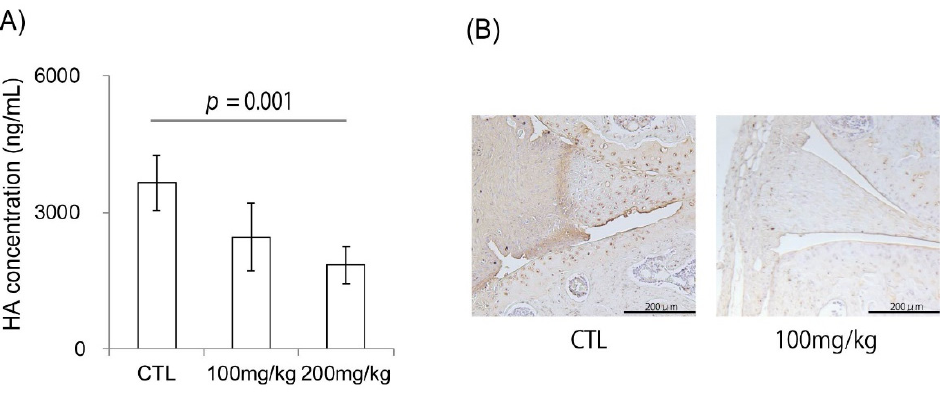
Figure 5. Effects of Ipriflavone on serum concentration and local accumulation of HA of CIA mouse model. ( A ) Serum concentration of HA (ng/mL) in control (CTL)-, Ipriflavone-treated mice (100 mg/kg or 200 mg/kg) on day 42. ( B ) Representative image of HABP staining for knee joints of control (CTL) and 100 mg/kg Ipriflavone treated CIA mouse model. Bar in ( B ) = 200 µ m.